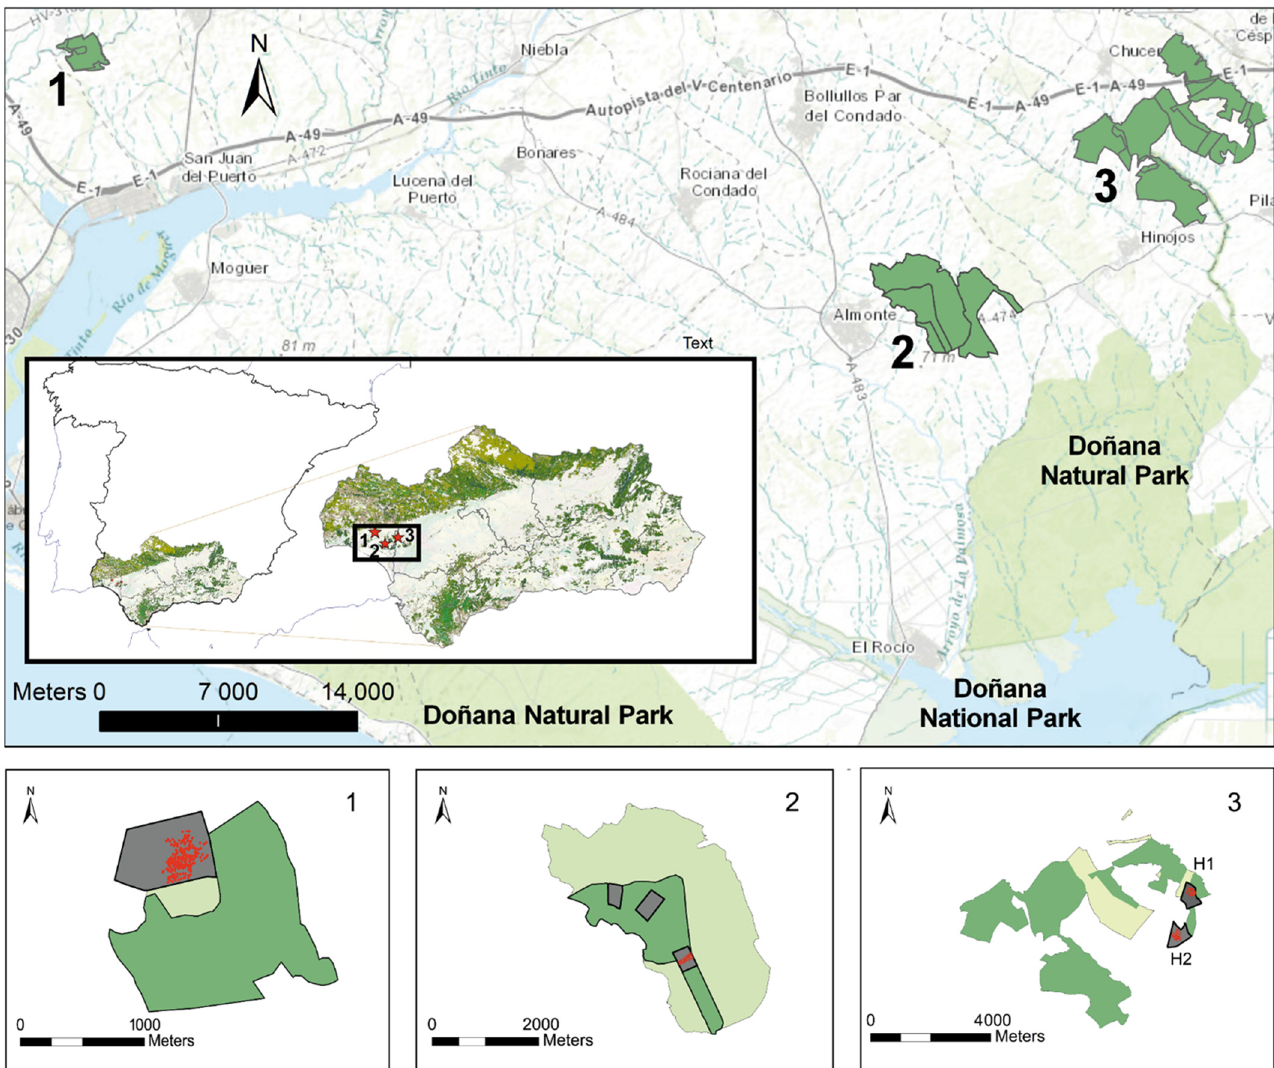
Figure 1. Dehesas considered in the study: 1, Gibrale ó n; (37 ◦ 22 (cid:48) 10.96 (cid:48)(cid:48) N, 6 ◦ 53 (cid:48) 37.69 (cid:48)(cid:48) O, 34 m.a.s.l.); 2, Almonte (37 ◦ 15 (cid:48) 43.73 (cid:48)(cid:48) N, 6 ◦ 28 (cid:48) 34.65 (cid:48)(cid:48) O, 80 m a.s.l.); 3, Hu é var. Above, patches of continuous woodland as constituted in 1957. Below, study plot and subplot scheme showing the constitution of the patches in 1977 (light green) and in 2010 (medium green). In dark gray, the study plots (H1 Hu é var1 − 37 ◦ 20 (cid:48) 34.55 (cid:48)(cid:48) N, 6 ◦ 19 (cid:48) 16.58 (cid:48)(cid:48) O, 67 m.a.s.l.-; H2, Hu é var2, − 37 ◦ 19 (cid:48) 40.24 (cid:48)(cid:48) N, 6 ◦ 19 (cid:48) 34.88 (cid:48)(cid:48) O, 111 m.a.s.l.-) and subplots (Almonte 3 subplots), within which is the location of the clusters (red